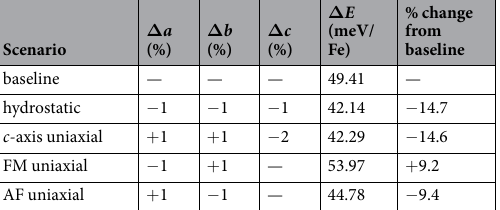
increase. A broad superconducting transition temperature in magnetic susceptibility was observed frequently for overdoped crystals, ascribed to most inhomogeneous cobalt-doping composition 19 . For annealed crystal with